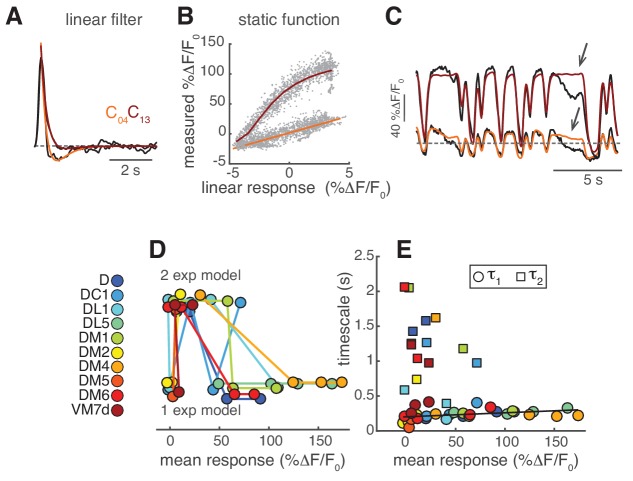
LN model for PN response.(A) The shape of the linear filter in PNs depends on stimulus intensity. Normalized linear filters (black) for the calcium responses of PNs in DM1 to two stimulus intensities and corresponding exponential fits (k3t in orange for C04 and k1t in dark red for C13). (B) Static function fitted at the two stimulus intensities: linear function in orange for C04 and Hill function in dark red for C13. (C) Measured calcium dynamics (black, n = 6–7) and calcium dynamics predicted by the corresponding LN model (orange and dark red) for the two stimulus intensities. Arrows indicate features that are not captured by the model. (D) Model selected as a function of the mean response. “1 exp” indicates a monophasic filter, “2 exp” indicates a biphasic filter. The model depends significantly on response amplitude (Kruskal-Wallis test, p<0.02). (E) Filter timescales as a function of mean response. Circles: τ1, first exponential (all models), squares: τ2 second exponential (model 3). τ1 is slightly correlated with the mean response (R = 0.4, p<0.02), whereas τ2 is independent from it (p>0.05). The black line represents a linear fit.